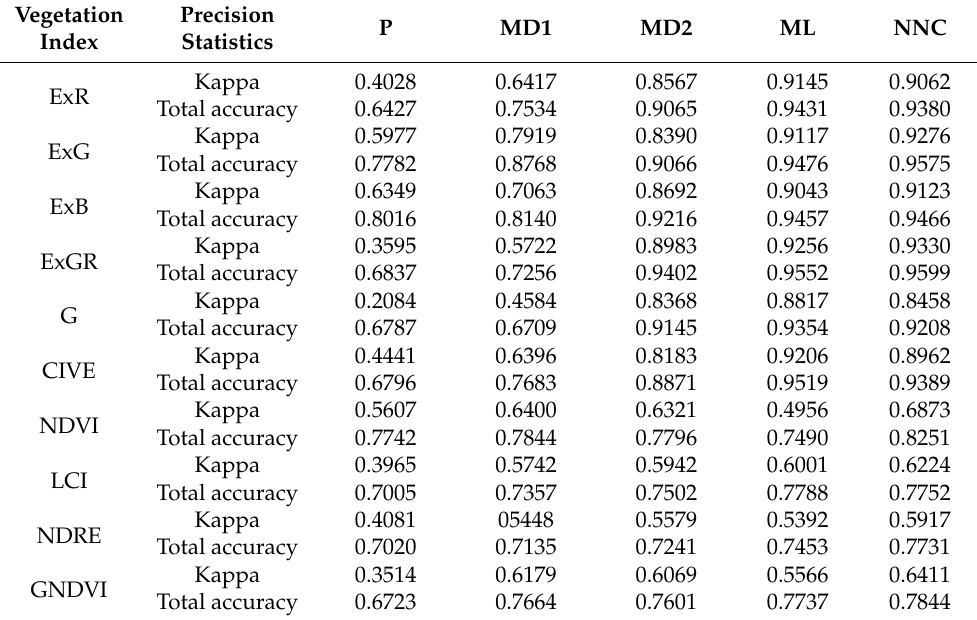
Table 4. Statistics for six visible light vegetation indices based on region of interest.